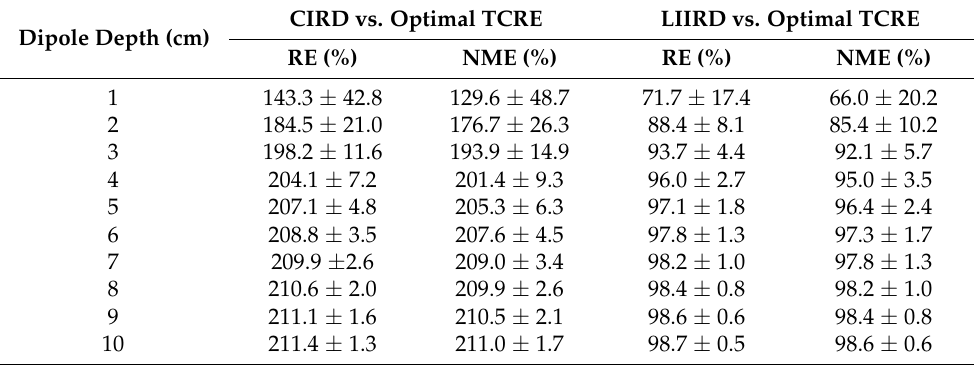
Table 3. Mean and standard deviation of the increases (%) in relative (RE) and normalized maximum errors (NME) for constant inter-ring distances (CIRD) and linearly increasing inter-ring distances (LIIRD) tripolar concentric ring electrode (TCRE) configurations, compared with the optimal one, for electrode dimensions ranging from 0.5 to 5 cm at each dipole depth (ranging from 1 to 10 cm). CIRD vs. Optimal TCRE LIIRD vs. Optimal Dipole Depth (cm)